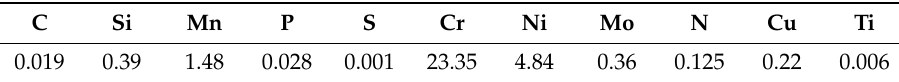
Table 1. Chemical composition (wt %) of DSS